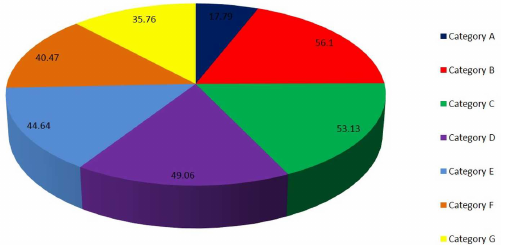
Fig 4. Classification of T . indica genes into 7 Categories based on Orthology analysis:CategoryA (only found in T . indica) ,CategoryB (found in both T . indica and U . maydis ), CategoryC (only found in both T . indica and U . hordei ),CategoryD (found in both T . indica and S . reilianum ),CategoryE (found in both T . indica and S . cerevisiae ), CategoryF (found in both T . indica and P . graministritici ), CategoryG (found in both T . indica and F . graminearum